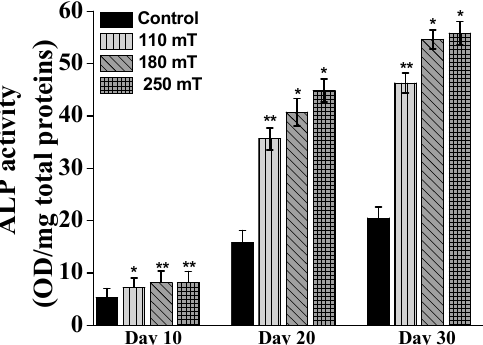
Figure 8. ALP (Alkaline Phosphatase) activity normalized to protein content for MG-63 osteoblast-like cells growing on ellipsoidal multilayered 3D structures having the layers spatially separated by cylindrical pillars, as a function of the applied static magnetic fields. Results for unstimulated samples (controls) are shown for comparison. Each bar represents the mean ± STD. Statistical significance was determined by Student’s t -test (* p ≤ 0.05, ** p ≤ 0.001).